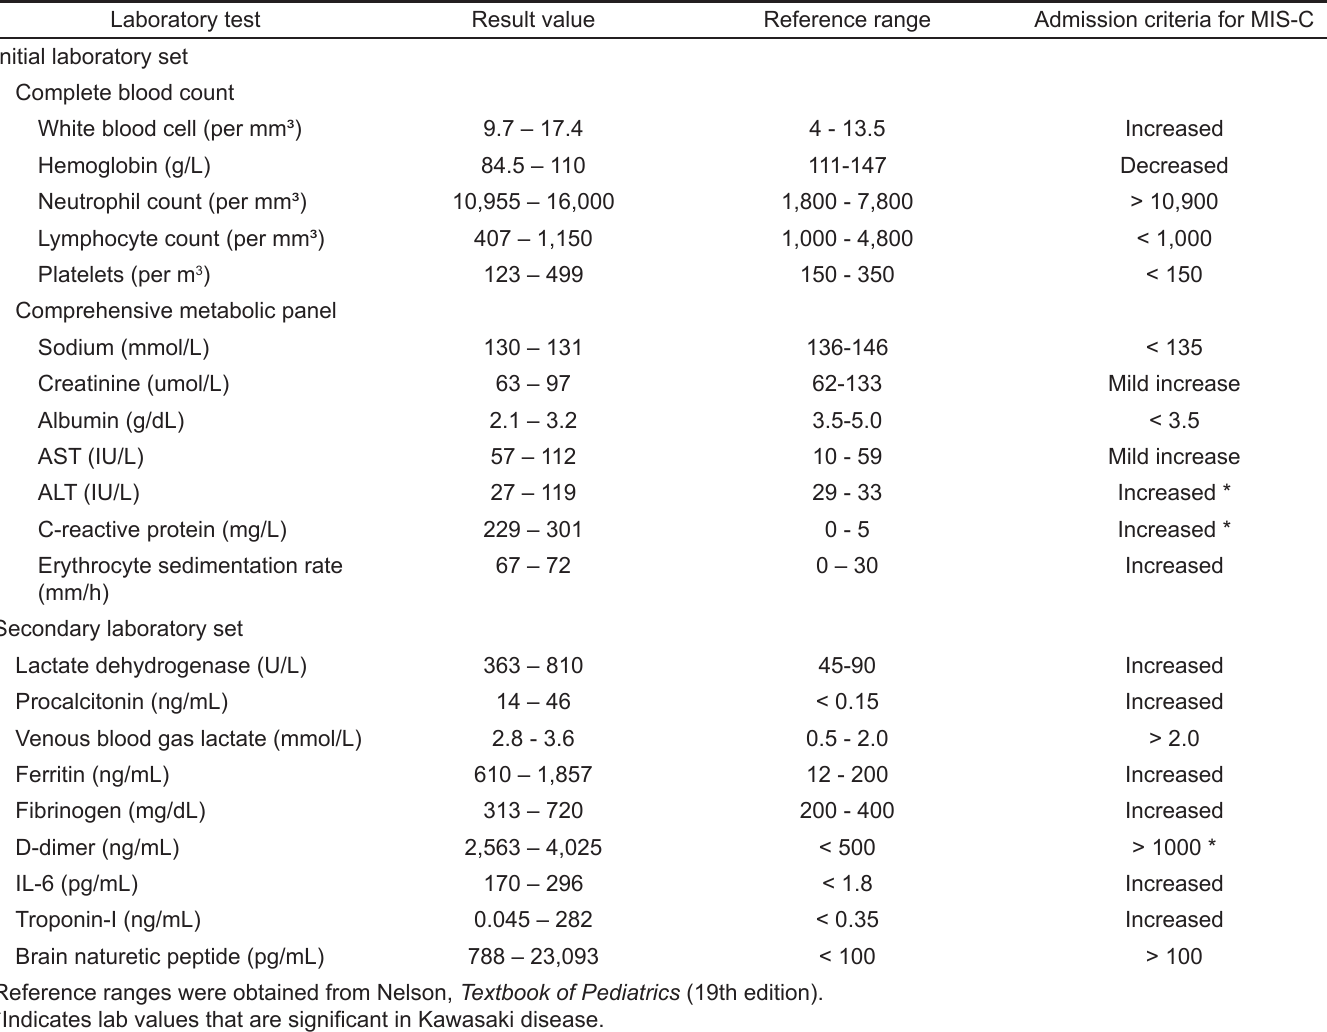
Table 2. Laboratory findings in cases of multisystem inflammatory syndrome in children. Range of mean values reported in currently available